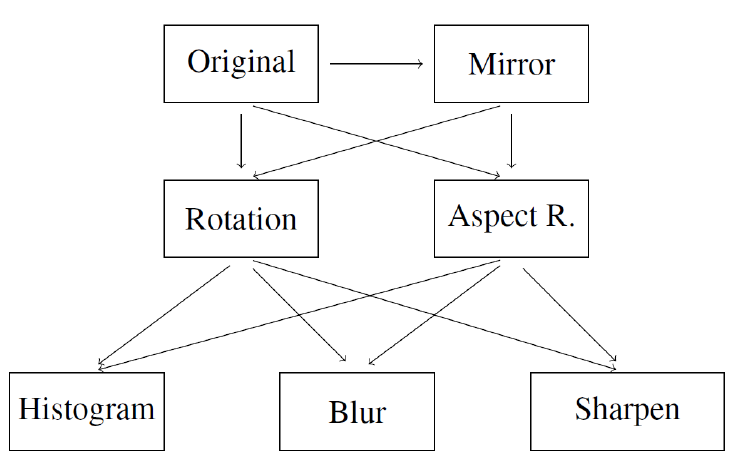
Figure 2. Augmentation schema for artificial data.